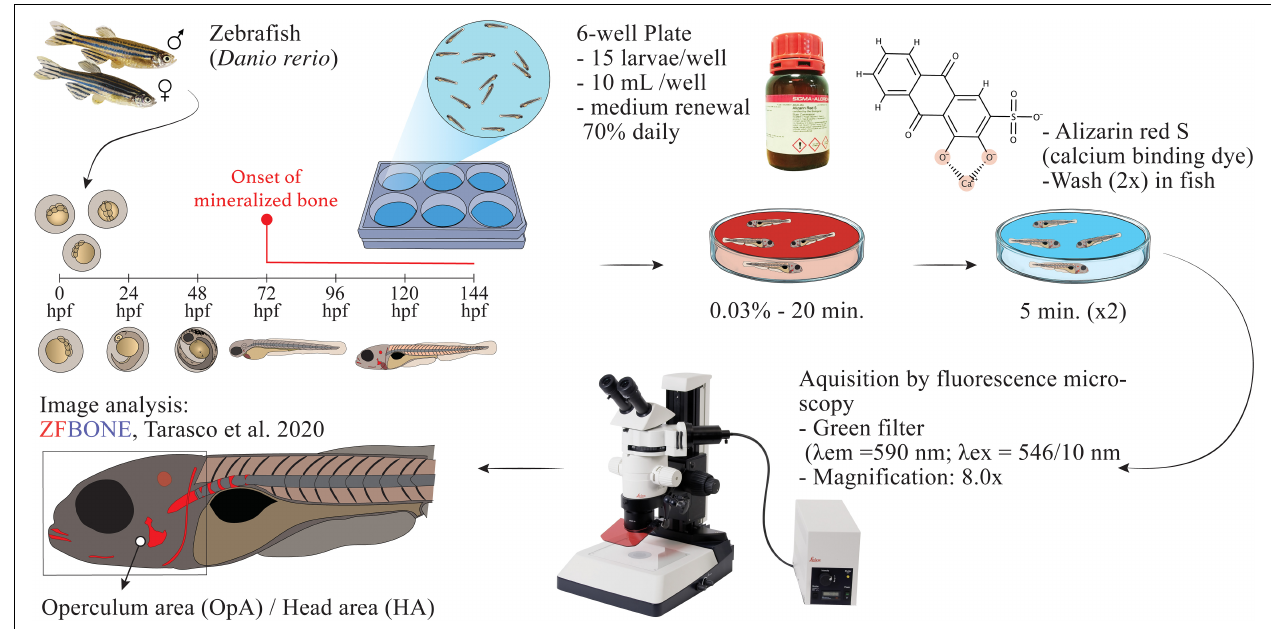
FIGURE 1 | Scheme of the protocol used for the evaluation of the osteogenic activity.